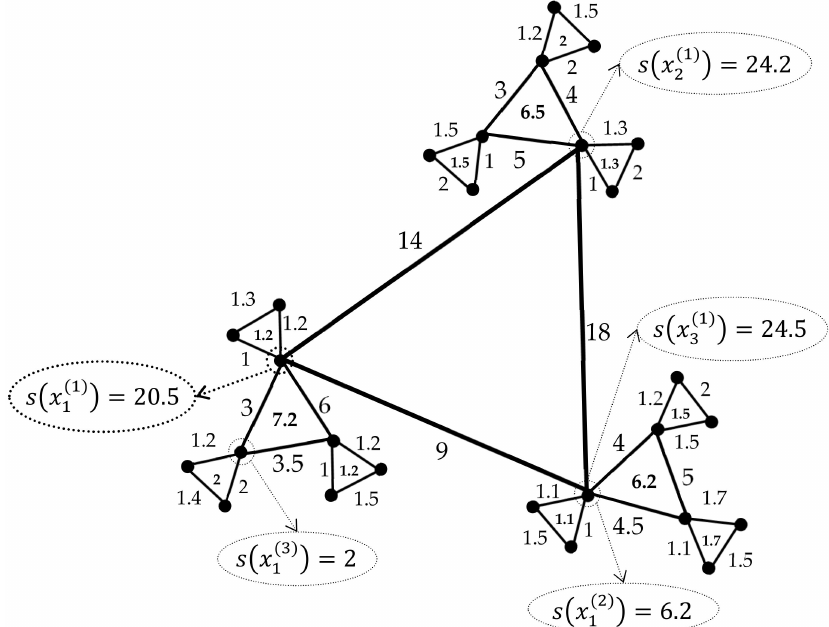
Figure 3. Computing the center of a weighted prefractal graph G 3 generated by a complete 3-vertex seed, the old edges of which are